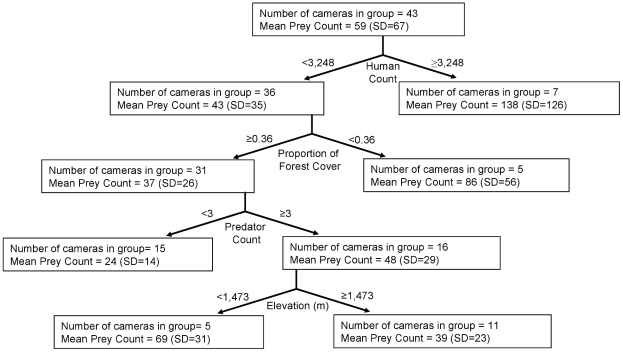
Regression tree analysis of large mammalian prey counts at camera sites in southwest Alberta, Canada during the summer of 2008.For each partition of the tree (indicated by arrows), the explanatory variable is shown with the value that best determines the partition (i.e., the cut-off point that maximizes homogeneity within a group). Indicated at each node are the number of cameras in the group and the mean number of prey photographs per 100 days (with standard deviation in parentheses).